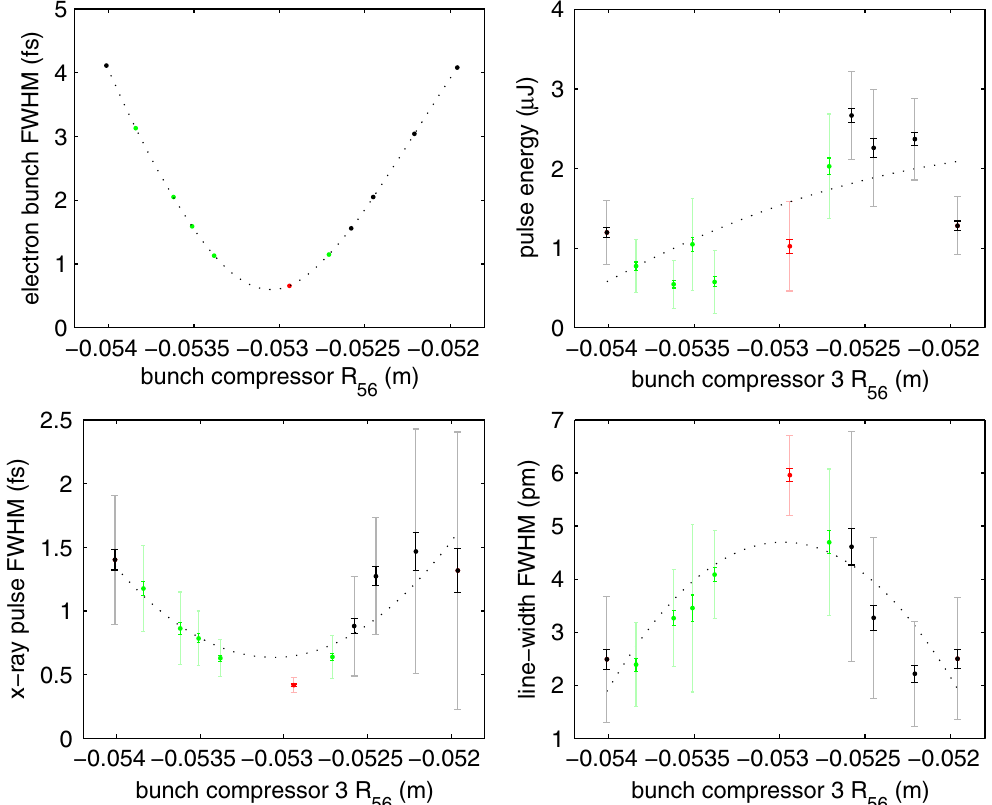
FIG. 14. Electron bunch and x-ray pulse properties as a function of bunch compressor strength taken as average values over 40 shot- noise seeds. Shown are plots of electron bunch length (top left), pulse energy (top right), x-ray pulse length (bottom left), and pulse linewidth (bottom right). Data for bunch lengths which produce single-spike behavior on the majority of seeds has been highlighted in green, and data for maximum compression in red. Bold error bars show the error on the mean values, and faint error bars show standard deviation over 40 shot-noise